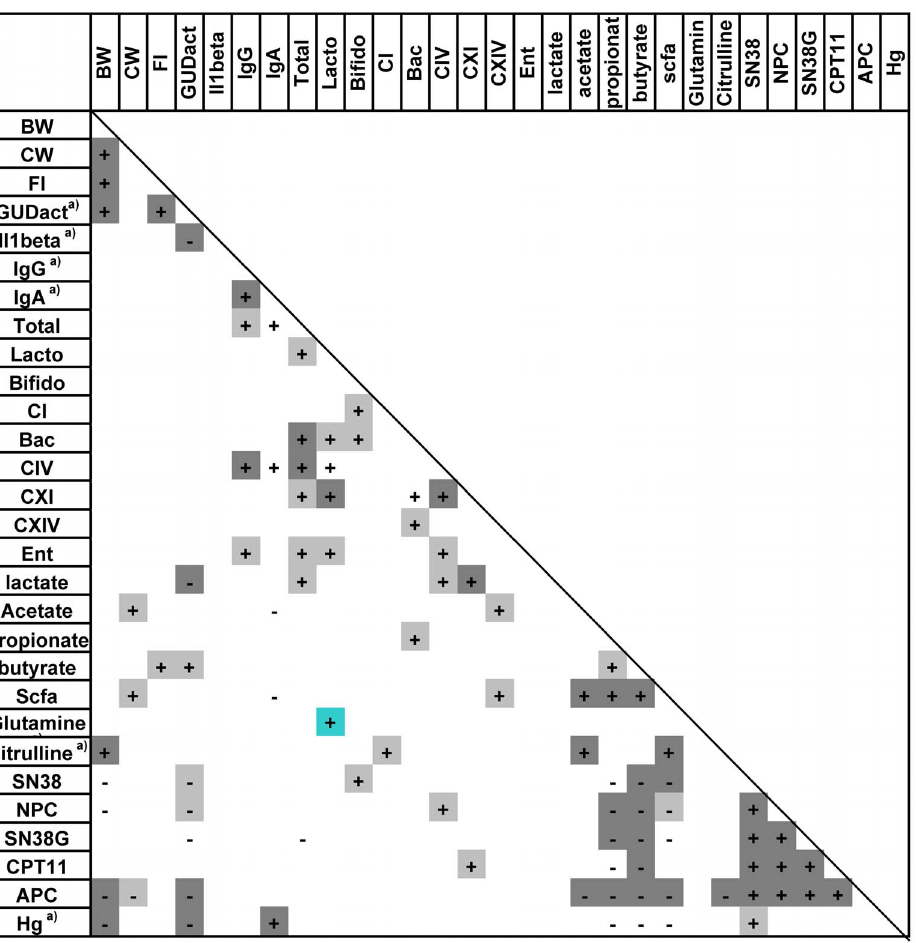
Figure 4. Pixel mapping highlights of major microbiota-host correlations of Exp 2. + indicates a positive correlation; - indicates negative correlation. Spearman correlation p-values are displayed as a greyscale, dark grey, p , 0.005; light grey, p , 0.05; no shading, trend (p , 0.1). Key: BW, relative body weight; CW, colon weight; FI, cumulative food intake; Total, total bacteria; Lacto, Lactobacillus group; Bifido, Bifidobacterium spp.; CI, Clostridium cluster I, Bac, Bacteroides group; CIV, CXI, CXIV, Clostridium clusters IV, XI, and XIV; Ent, Enterobacteriacaea ; scfa, short chain fatty acids; hg, haptoglobin.